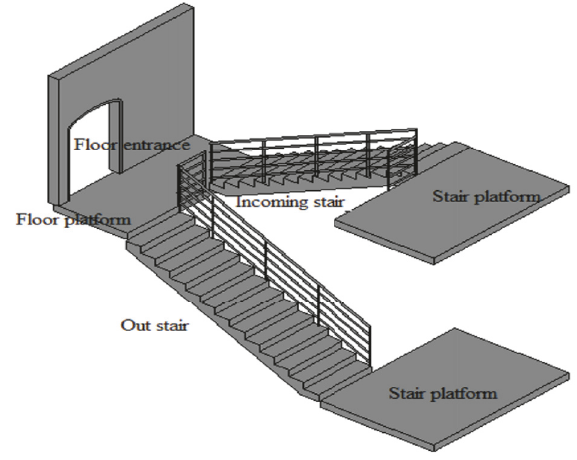
Figure 1: The structure and structure name of the